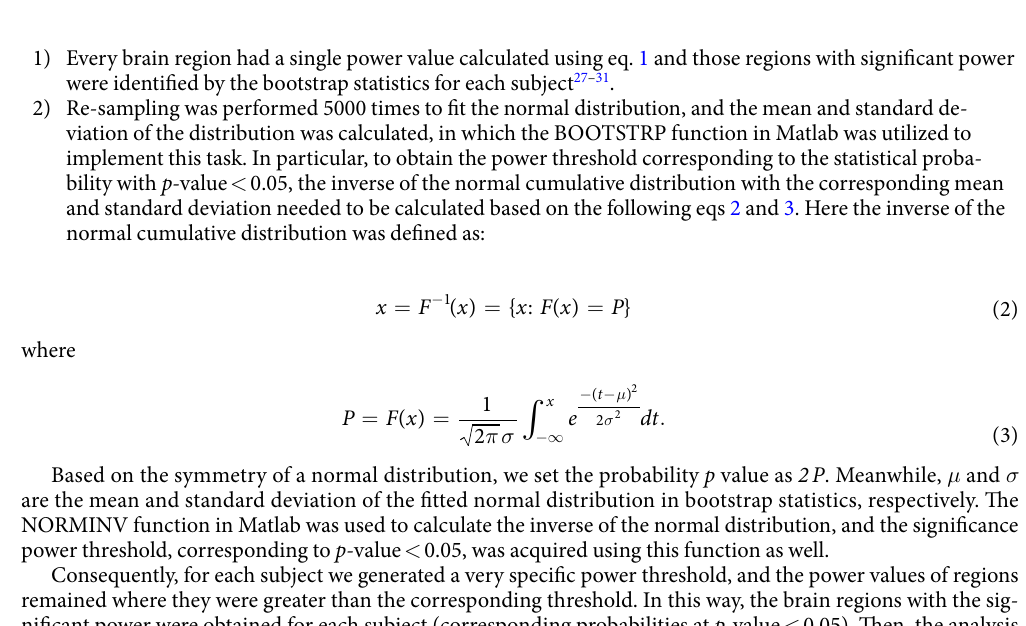
Figure 2. Power of brain regions and the standardized z-scores (mean ± SE): ( a ) Power curves (the unit for 10 log 10 Power is decibels); ( b ) Standardized z-score curves. The blue color represents the CD group whereas the orange line represents the TD group. The horizontal axes denote the ninety anatomical regions of interest from the AAL template. The vertical axes in ( a , b ) denote the power of brain regions and standardized z-scores of power values,